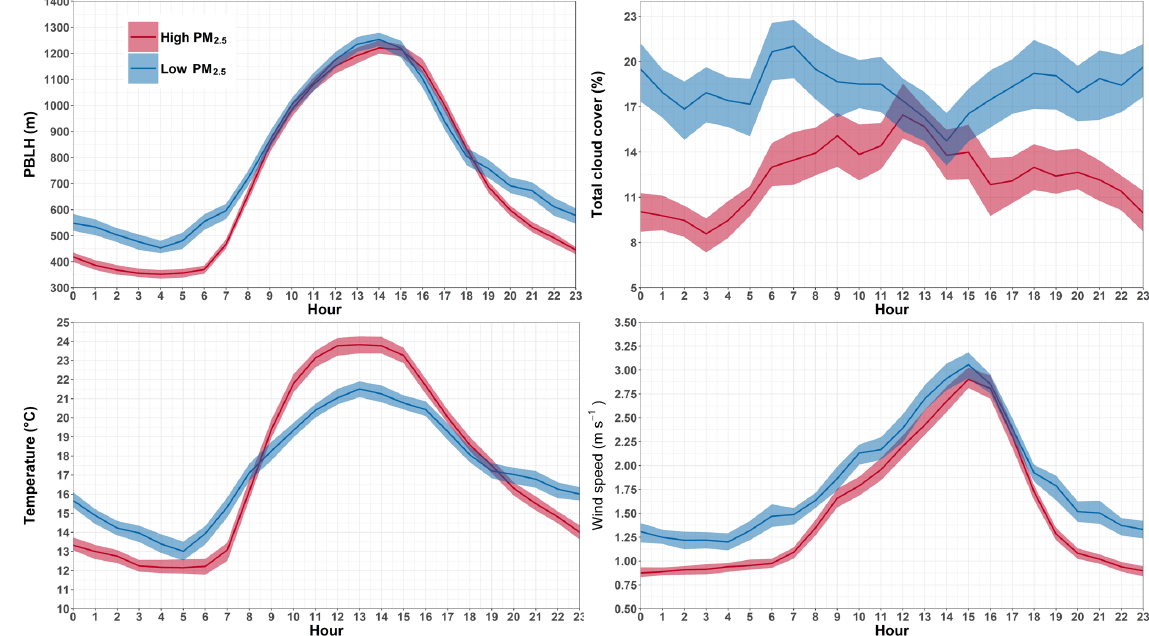
Figure 11. Mean diurnal variation of hourly PBLH, total cloud cover, temperature and wind speed for low versus high PM 2 . 5 pollution during HRBs at Liverpool, Sydney (see Figs. S8–S10 for other stations). Shading represents the 95% confidence intervals of the